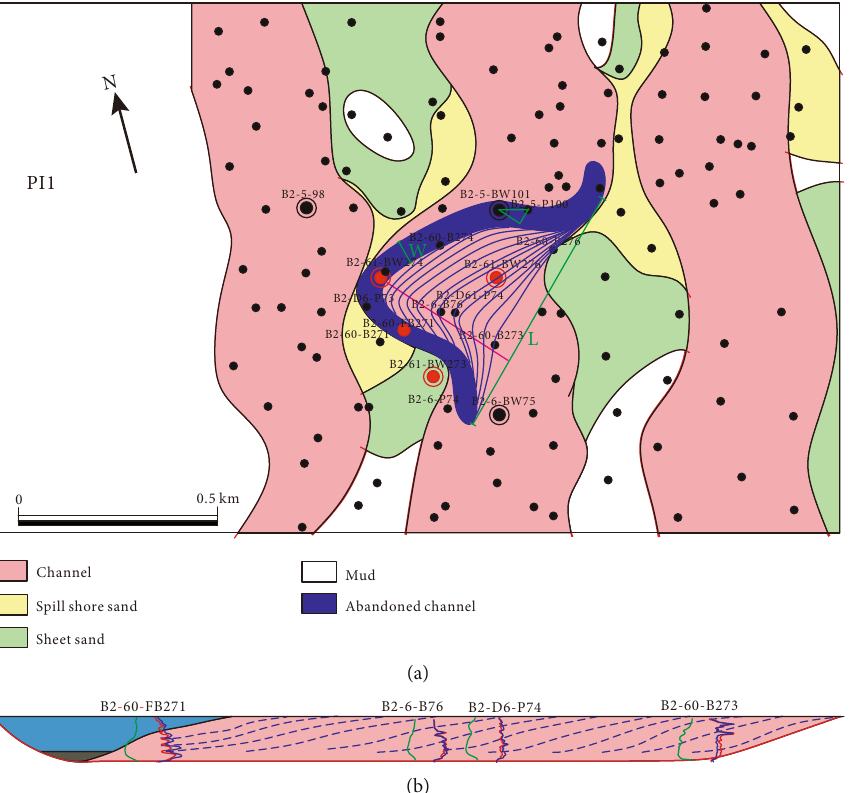
Figure 4: (a) Plan view of the channel width in the PI1 layer. (b) Pro fi le of the channel width in the PI1